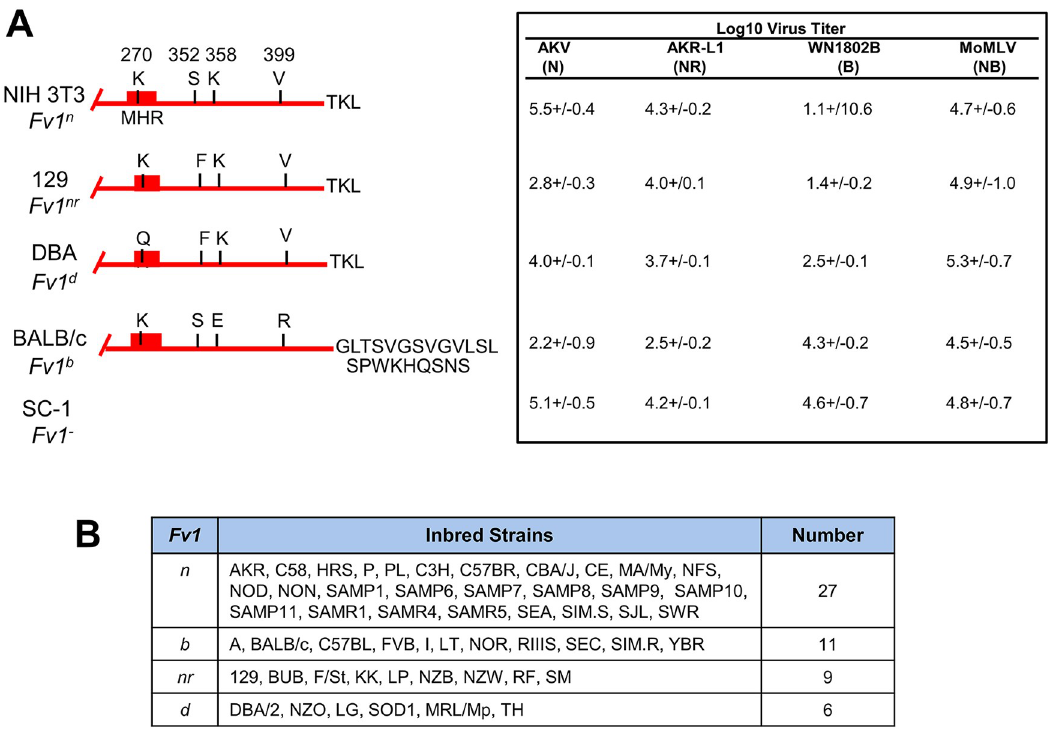
Fig 6. Fv1 variants in classical inbred strains. A) The diagrams on the left identify protein sequence differences among the 4 inbred strain alleles. On the right are virus titers for E-MLVs sensitive to Fv1 restriction as determined for NIH3T3 ( Fv1 n ), 129 ( Fv1 nr ), DBA ( Fv1 d ), BALB3T3 ( Fv1 b ), and the wild mouse derived SC-1 ( Fv1 - ). Log 10 virus titers were determined by the UV-XC overlay assay; each cell line was tested 3–8 times. B) Inbred strains sequenced for Fv1 alleles. Identical Fv1 d sequences were found for substrains DBA/2N and